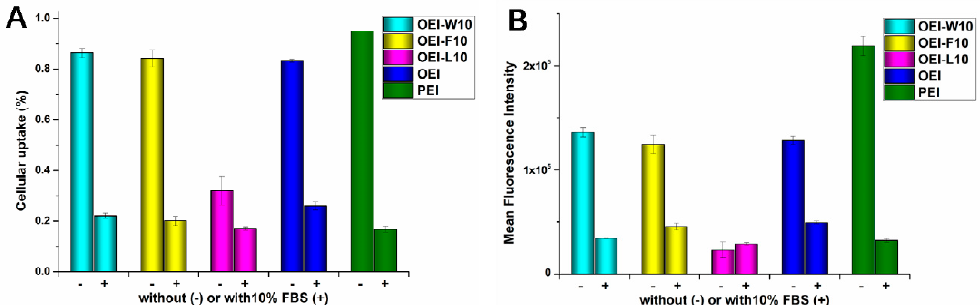
Figure 7. Cellular uptake of polyplexes at the optimal transfection w / w ratio in HeLa cells quantified by flow cytometry analysis. ( A ) Percentage of uptake cells; ( B ) mean fluorescence intensity of transferred DNA. Data represent mean ± SD ( n = 3).